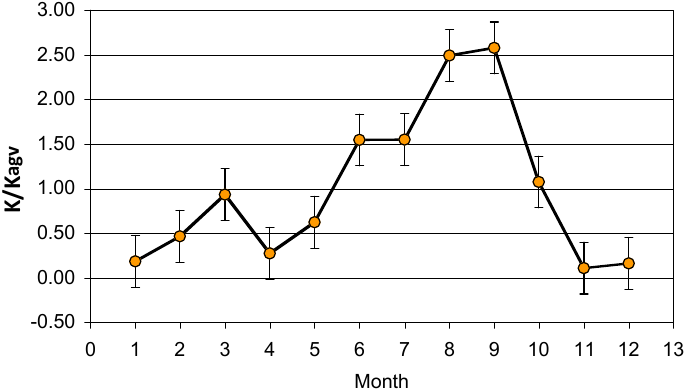
Figure 14. Relative k-values over the course of the year for five STA large P wetlands (STA2C1, STA2C2, STA2C3, STA34 East, STA34 West). Data have been normalized by the long-term mean K-value for each wetland. Error bars are the average standard deviation for all months.